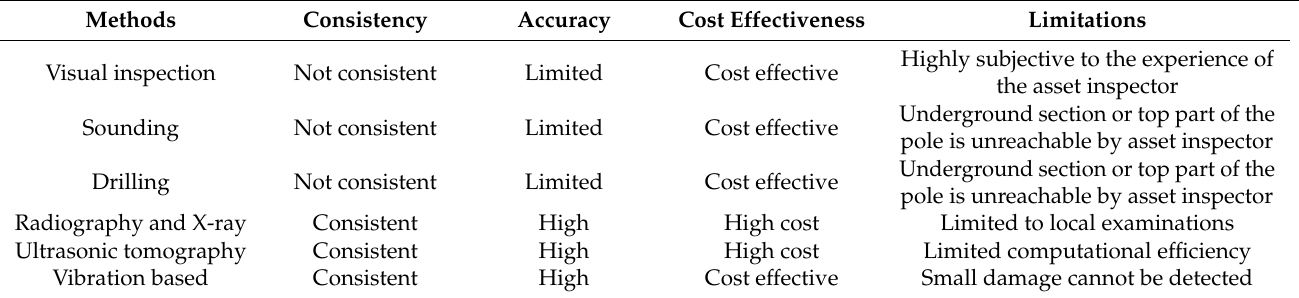
Table 1. Comparison of the reviewed non-destructive testing (NDT) methods for this study.